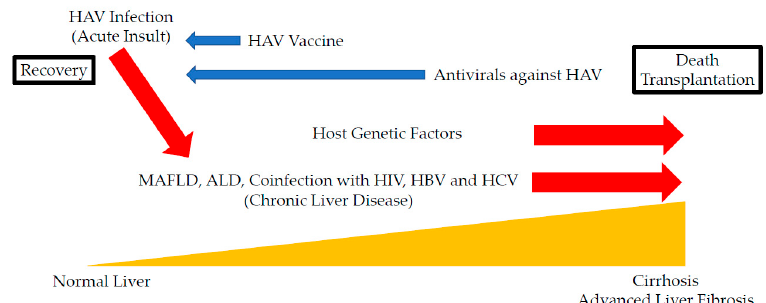
Figure 1. E ff ects of hepatitis A infection (HAV) on the prognosis of chronic liver disease. Possible acceleration and inhibition of the disease progression of hepatitis A are indicated by red and blue arrows, respectively. MAFLD, metabolic associated fatty liver disease; ALD, alcoholic liver disease; HIV, human immunodeficiency virus; HBV, hepatitis B virus; HCV, hepatitis C virus. 10.2. Japanese Rice-Koji Miso Extracts and Zinc Sulfates Could Inhibit HAV Replication with the Enhancement of GRP78 Expression